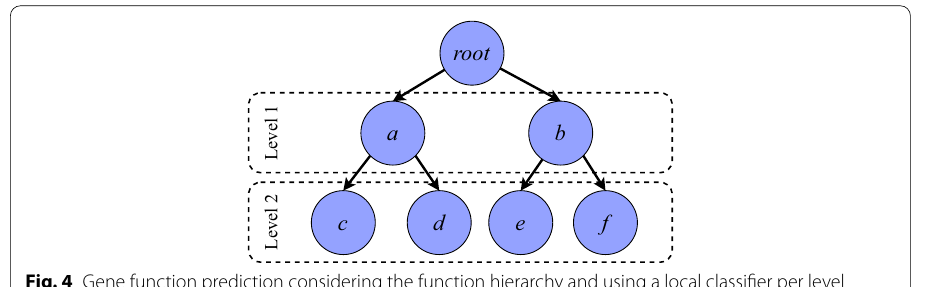
Fig. 4 Gene function prediction considering the function hierarchy and using a local classifier per level method. The predictor for the level 1 predicts functions a and b , so only the features from J ′ G and J ′ F associated to functions a and b are considered for the feature